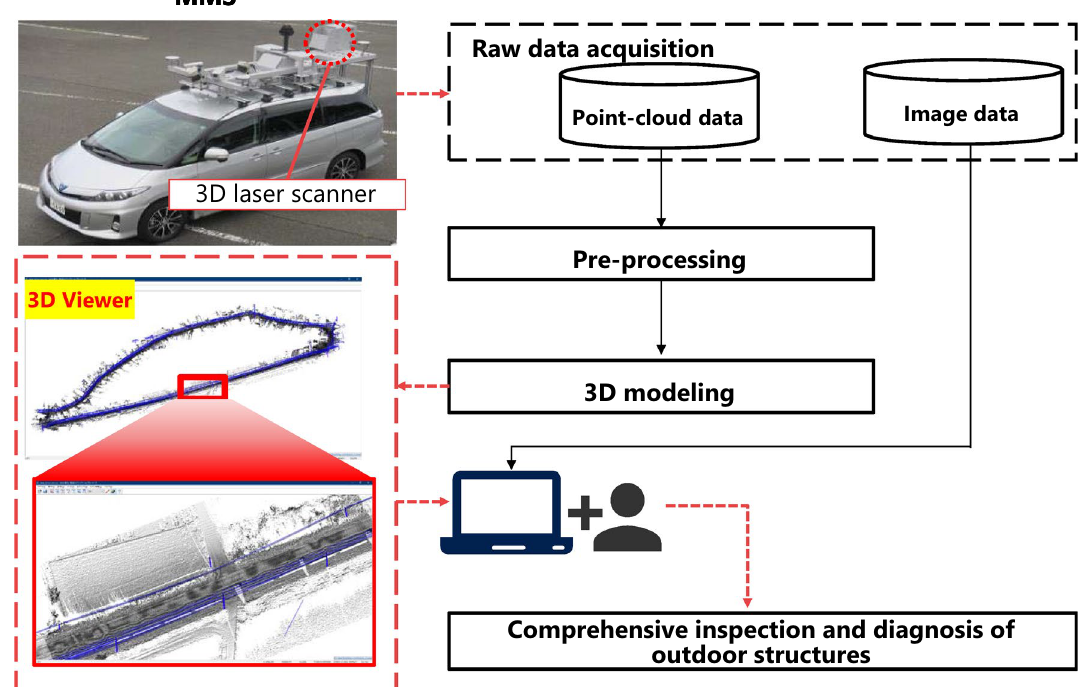
Fig. 1 Inspection and diagnosis process for outdoor communication